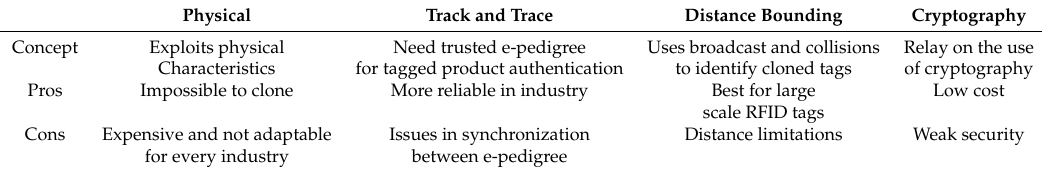
Table 2. Pros and Cons of each RFID anti-counterfeiting technique or